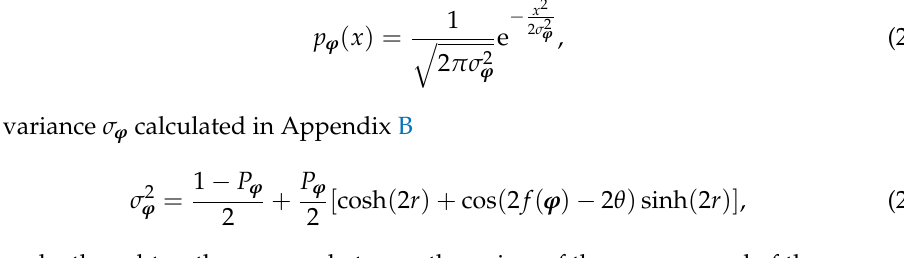
Figure 3. Diagram of the setup described in Section 4.1 [37]. A squeezed vacuum state is injected in the first input port of a network composed of a first auxiliary stage ˆ V in , a linear and passive network ˆ U ϕ which depends on multiple unknown parameters ϕ , and a second auxiliary stage auxiliary stages are linear and passive networks whose purpose is to manipulate how the information on ϕ and on the structure of the network is encoded into the probe, and to refocus it in the only output channel observed through homodyne detection. This setup reaches the Heisenberg limit in the estimation of the overall phase acquired by the probe, which is a function of the parameters ϕ that can be manipulated through the choice of ˆ V in and ˆ V out